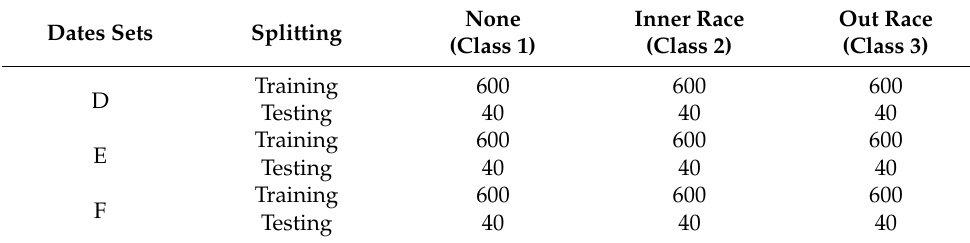
Table 14. Detail of datasets on Paderborn.